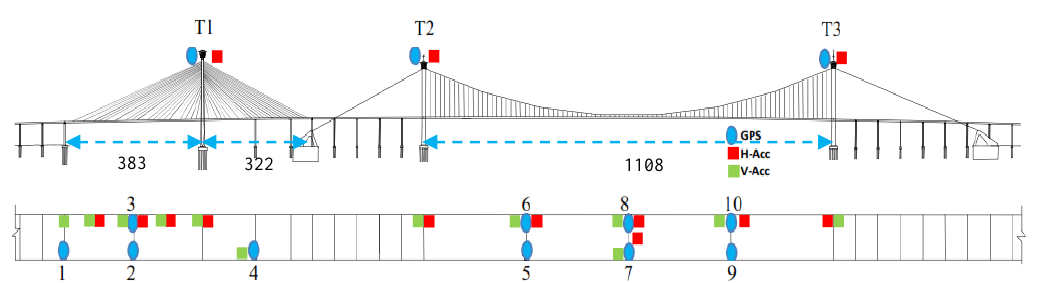
Figure 1. Huangpu bridge view.